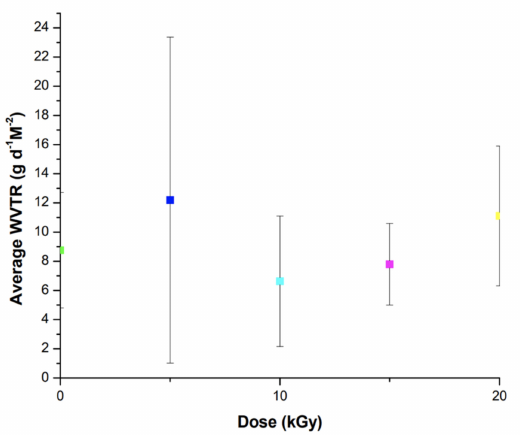
Figure 10. ( a ) Polymer dispersity as a function of absorbed dose of 0, 5, 10, 15, and 20 kGy, where dispersity is the weight average over number average molar mass; ( b ) number average molar mass M n versus absorbed dose of 0, 5, 10, 15, and 20 kGy.